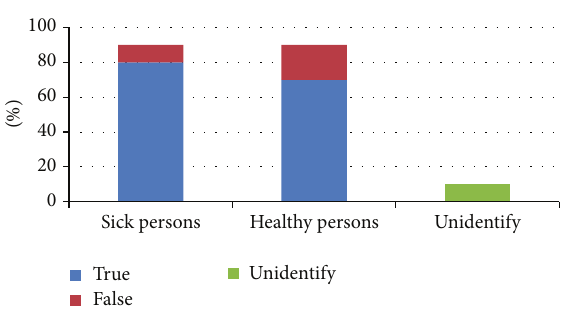
Figure 11: Experimental results, test error.